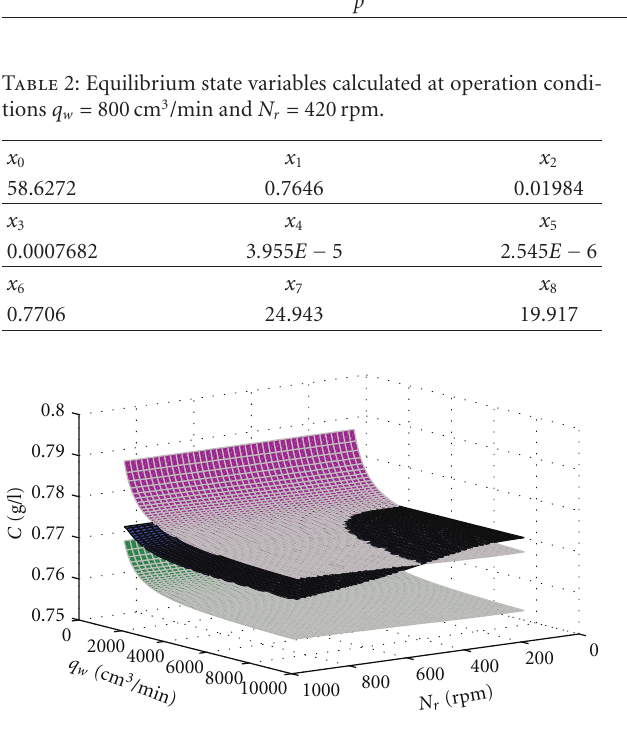
Figure 1: Steady-state concentration and metastable zone limits at di ff erent operating